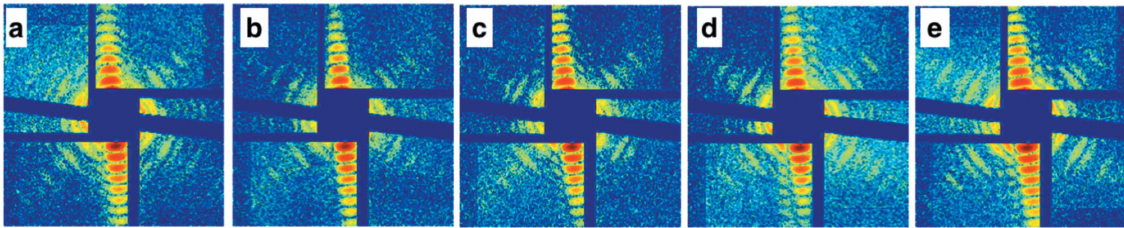
Figure 7 Scattering patterns from particles at the same orientation. The dominant signals (vertical series of speckles) are from the shell and the weaker signals are due to the presence of the Au core. The particles have very similar sizes, indicated by the q spacing between the